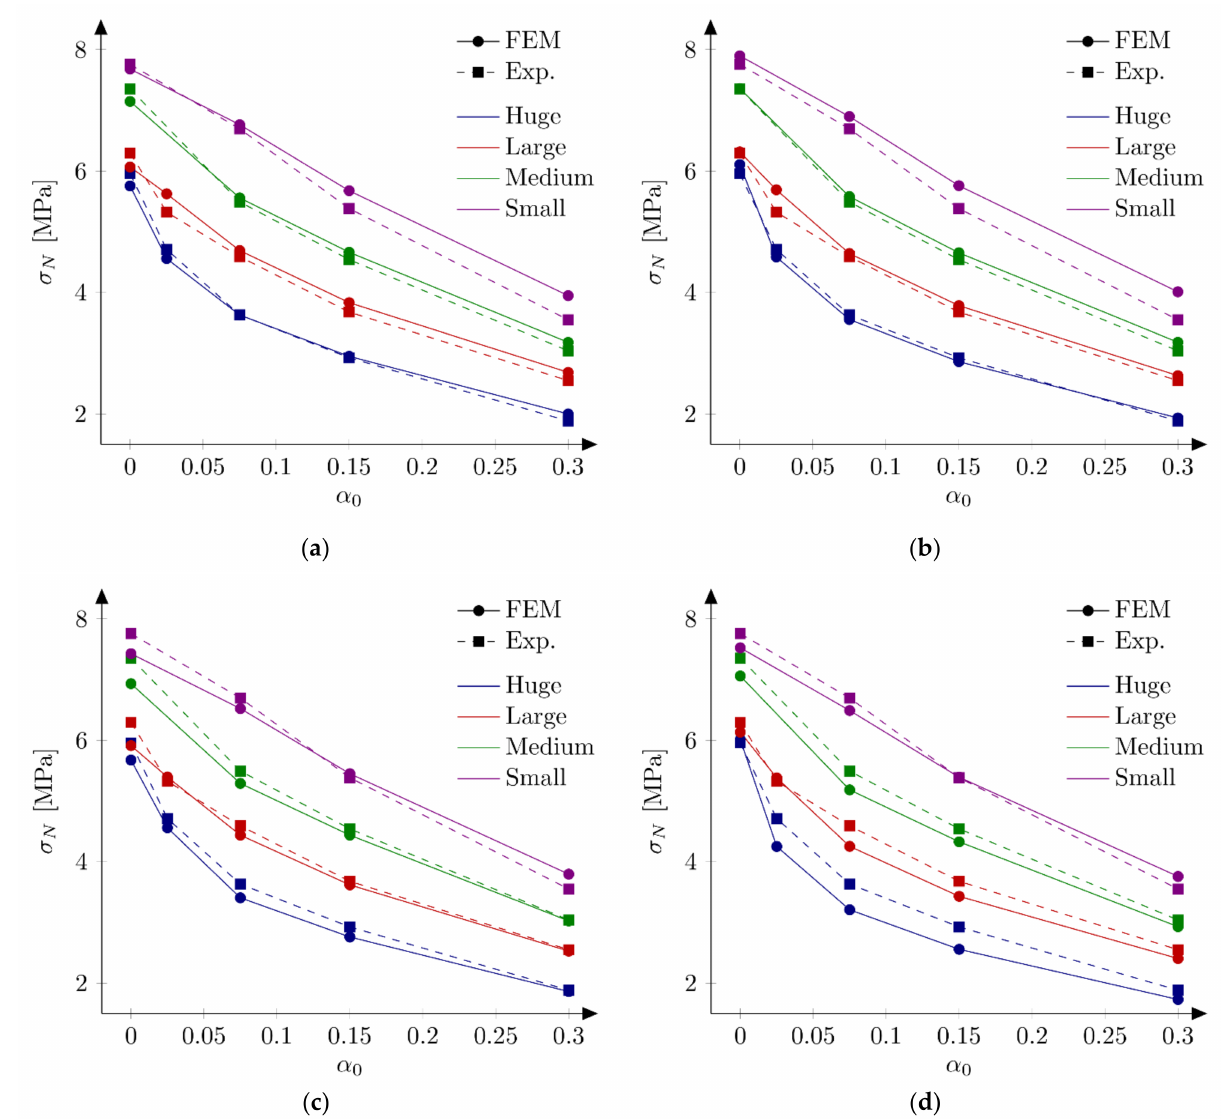
Figure 7. Nominal and experimental strengths with bilinear softening law and: ( a ) set S1: f t = 4.8 MPa and G f = 48 N/m; ( b ) set S2: f t = 5.2 MPa and G f = 42 N/m; ( c ) set S3: f t = 4.8 MPa and G f = 40 N/m; ( d ) set S4: f t = 5.2 MPa and G f = 32 N/m. placements for all beams and parameters set S1. Red points indicate the moment when the maximum force is obtained. The crack length L crack at the peak is in range 1.4–1.6 cm ( L crack / D = 0.35–0.40), 2.3–2.6 cm ( L crack / D = 0.25–0.28), 3.4–3.8 cm ( L crack / D = 0.16–0.18) and 3.9–4.9 cm ( L crack / D = 0.08–0.10) for small, medium, large and huge beams, respec- tively. The larger the beam is assumed, the smaller the relative crack length is obtained [63]. For small beams a crack is always fully developed (a large horizontal plateau) while for the huge beams a crack is still to propagate (no horizontal plateau). In general, at the peak a crack is far away from being fully